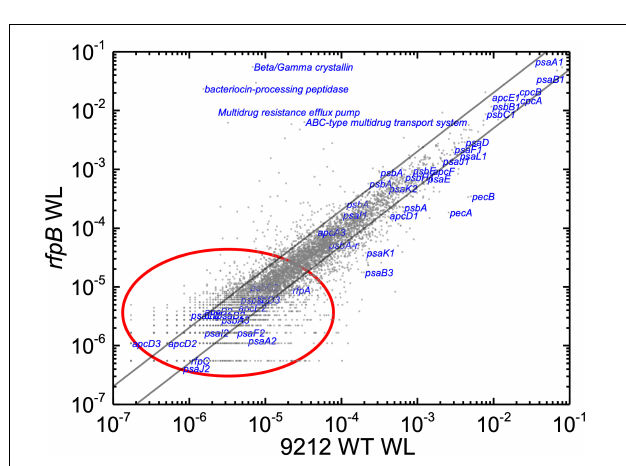
FIGURE 2 | Scatter plot showing a comparison of relative transcript abundances for C. fritschii 9212 cells grown in FRL compared to WL. Scatter plot of RNAseq data comparing relative transcript abundance for WT C. fritschii PCC 9212 cells grown in FRL for 48 h (9212 WT FRL) and WL (9212 WT WL). Each gray dot represents one gene. The X - and Y -axes represent normalized transcript abundances for each condition. Genes of interest, including genes in FaRLiP gene cluster (red circle) and genes encoding PSI, PSII, and PBP/PBS subunits are labeled in blue font. The green circle shows some genes, including apcE1 , cpcBA , and psaA1B1 that are normally highly expressed in WL but have much lower relative transcript abundances in FRL. The diagonal lines indicate the thresholds for a twofold increase and a 50% reduction in relative transcript abundance, respectively.